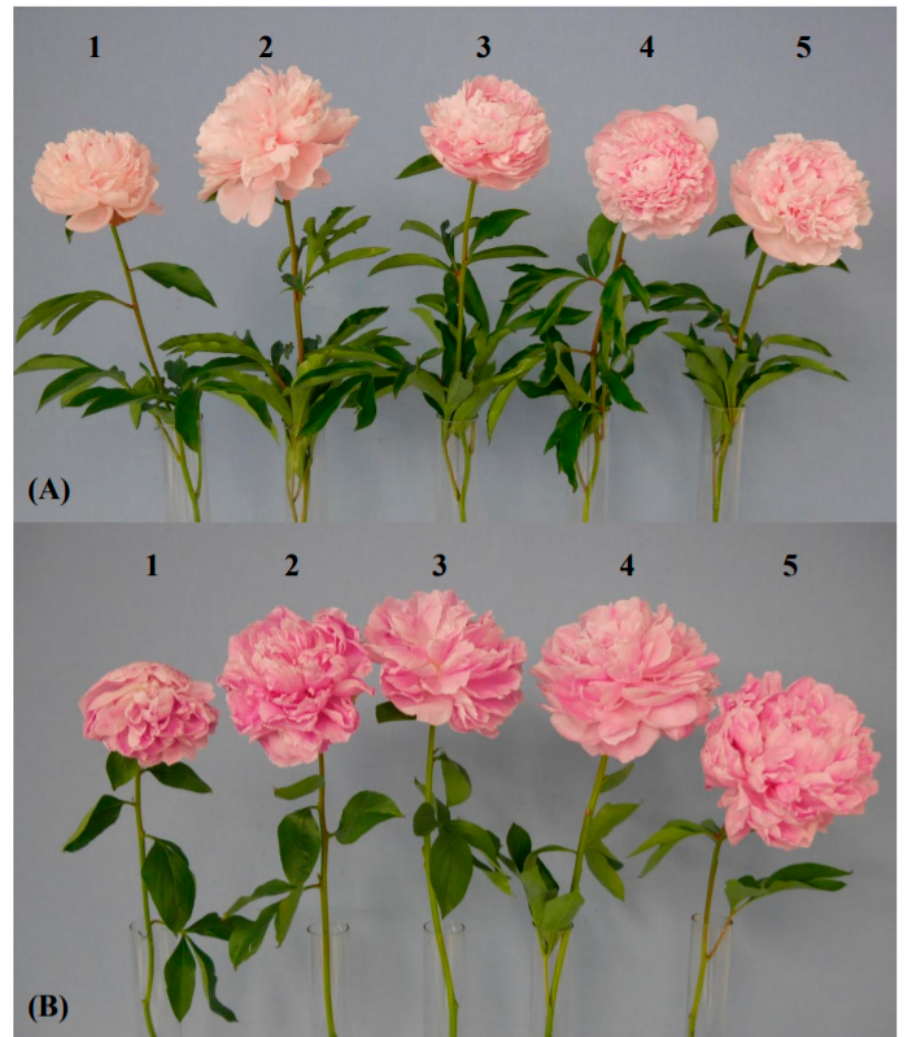
Figure 1. Appearance of cut peony ‘Albert Crousse’ ( A ) and ‘Ursynów’ ( B ) flowers placed into